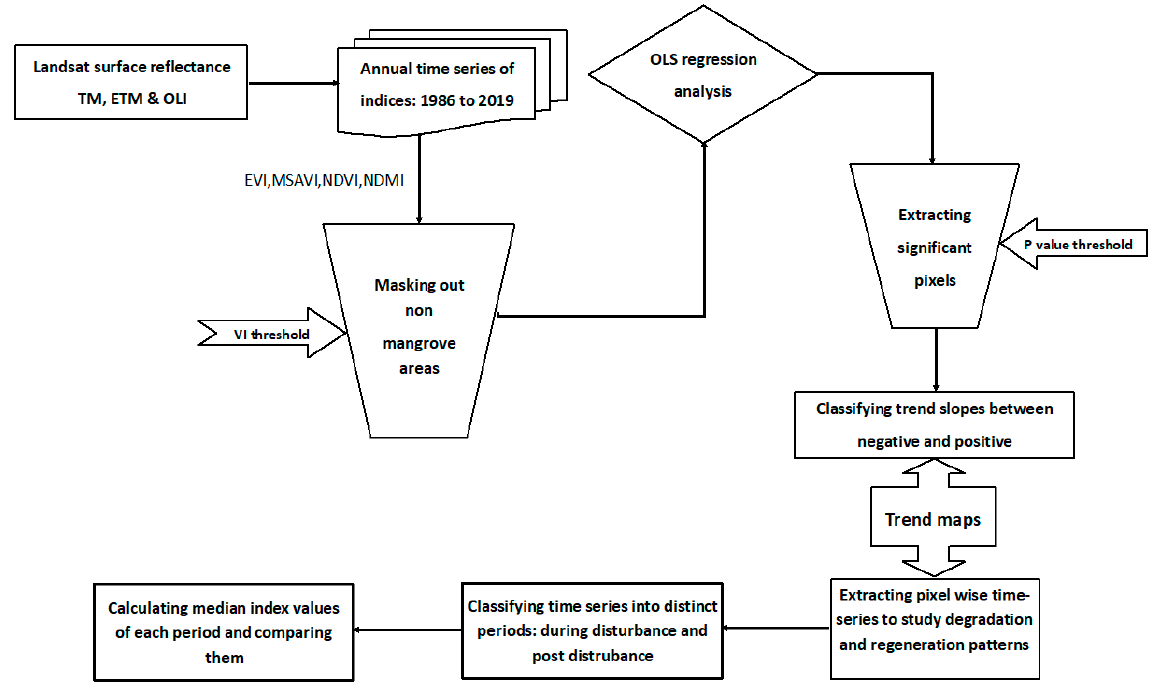
Figure 3. Framework for data acquisition and analysis.